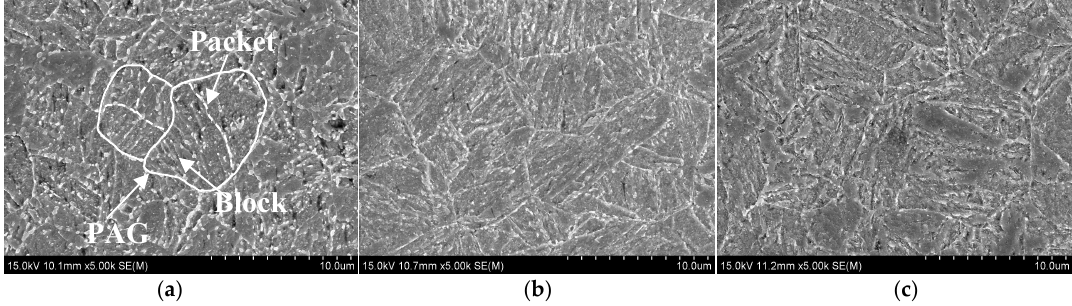
Figure 7. Typical SEM observations of martensitic packet in Q&T–treated samples at differing T t of ( a ) 650; ( b ) 700; and ( c ) 720 ◦ C.